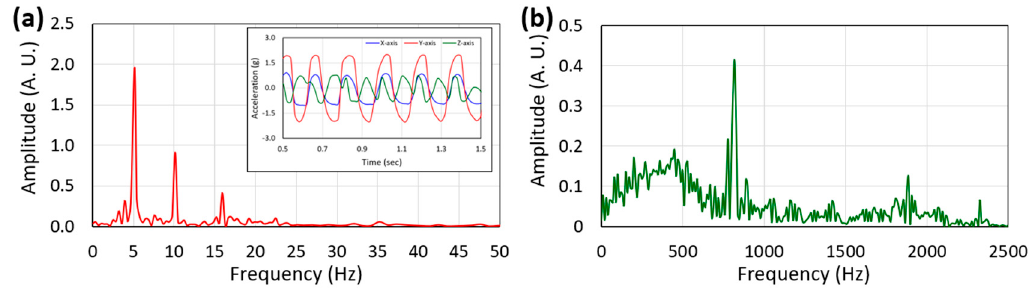
Figure 8. Frequency components (FFT) of the applied excitation (along Y-axis) obtained from the accelerometer data (inset) during the test ( a ) and the voltage waveform generated by the piezoelectric transducer ( b ).